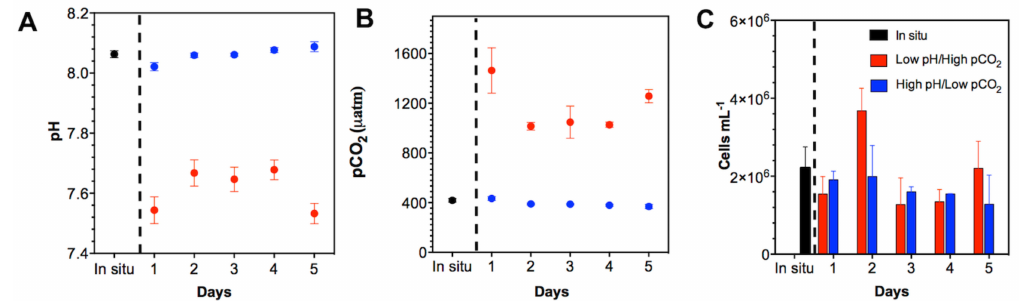
Figure 4. Characterization of the environmental variables in microcosm: ( A ) pH; ( B ) p CO 2 ; ( C ) Cellular abundance. The black circle represents oceanic water from station T5 (In situ); the blue circle represents the control treatment high pH / low p CO 2 , and the red circle represents treatment under pH / high p CO 2